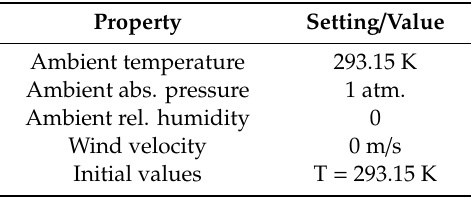
Table 1. Settings for creeping flow interface.